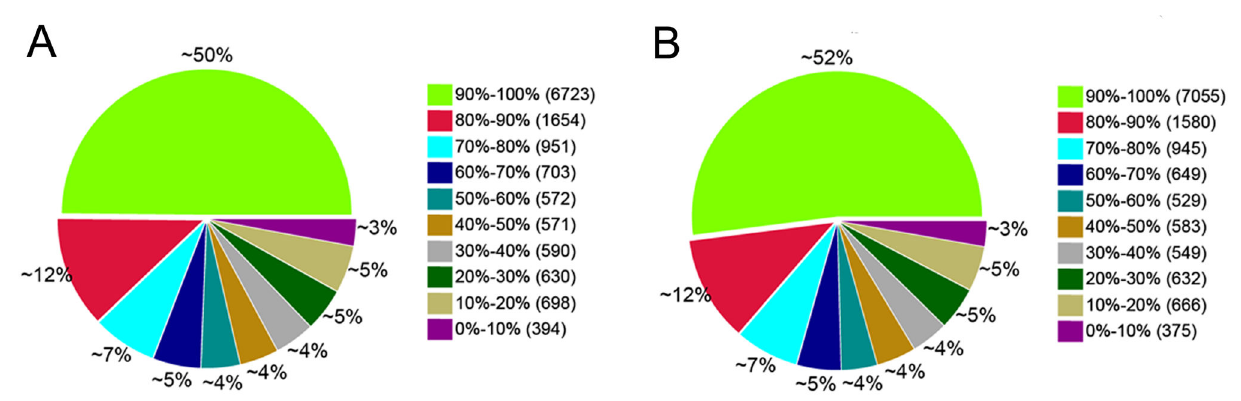
Figure 4. Distribution of genic coverage in the two ovine transcriptomes. A , DP; B, SH . Gene coverage is the percentage of a gene covered by reads. This value is equal to the ratio of total base count in a gene covered by uniquely mapped reads to the total base count for that gene. The read distribution is similar in both RNA-seq libraries, with approximately 50% of the reference genes having 90%-100% coverage. doi: 10.1371/journal.pone.0072686.g004 the 27 sheep chromosomes (26 autosomes and 1 allosome).